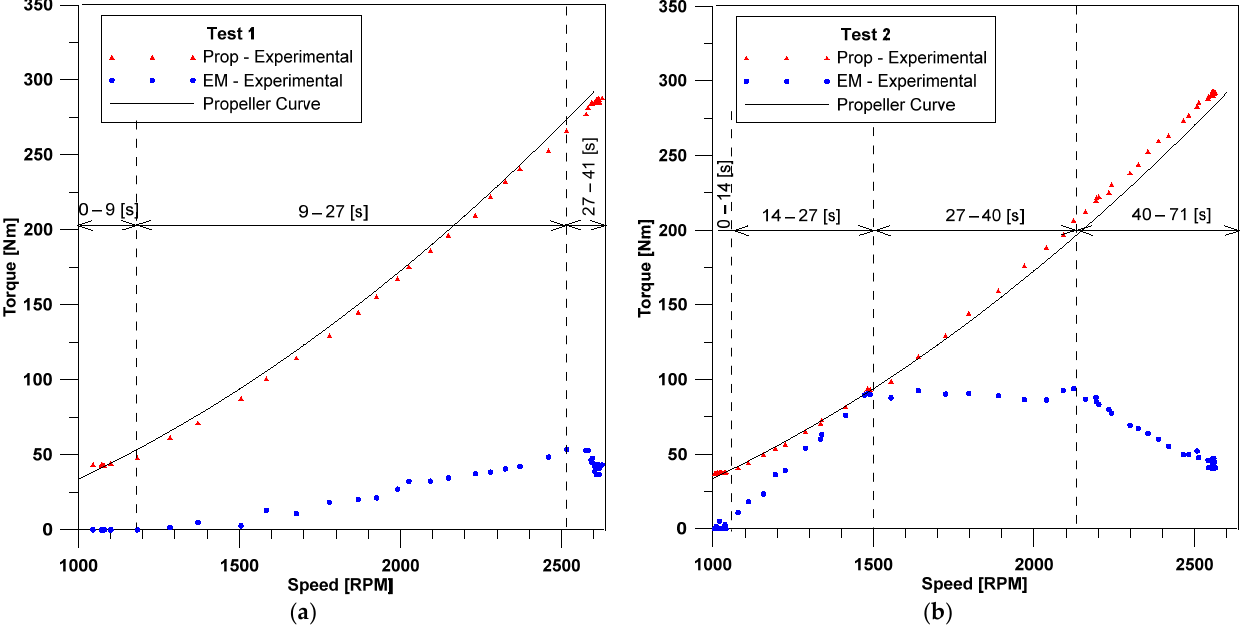
Figure 2. Experimental tests torque–rotational speed measurements: ( a ) Test 1; ( b ) Test 2.